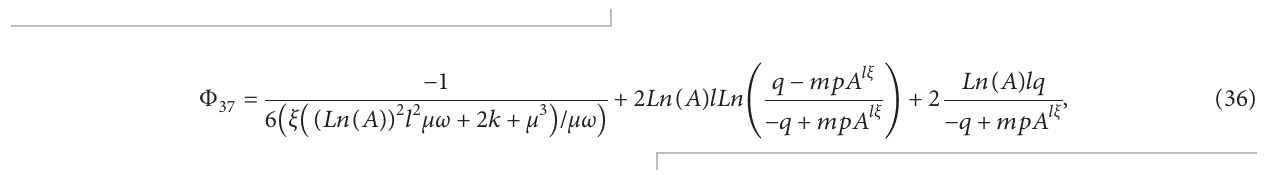
Figure 1: 3D profile of Family 13 with α � 1 . 5, β � 2, k � y � 1, ω � 0 . 5, p � q � 0 . 9, μ � 0 . 25, σ � 0 . 75, and A � 2 . 5. (a) | Φ | . (d) | Φ | . (e) | Φ | (c) | Φ 3 4 5